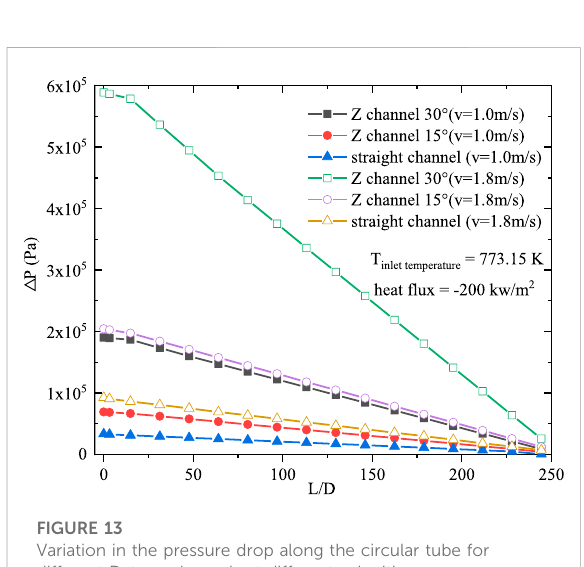
FIGURE 13 Variation in the pressure drop along the circular tube for different D-type channels at different